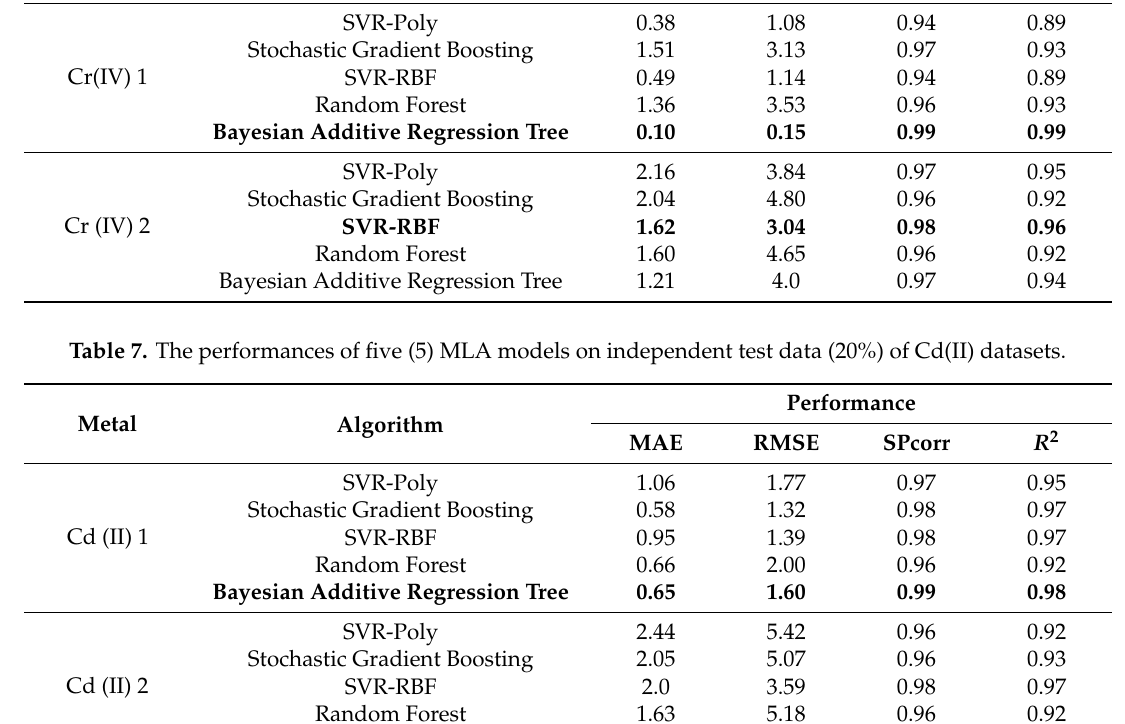
Table 6. The performances of five (5) MLA models on independent test data (20%) of Cr(IV) datasets. Metal Algorithm